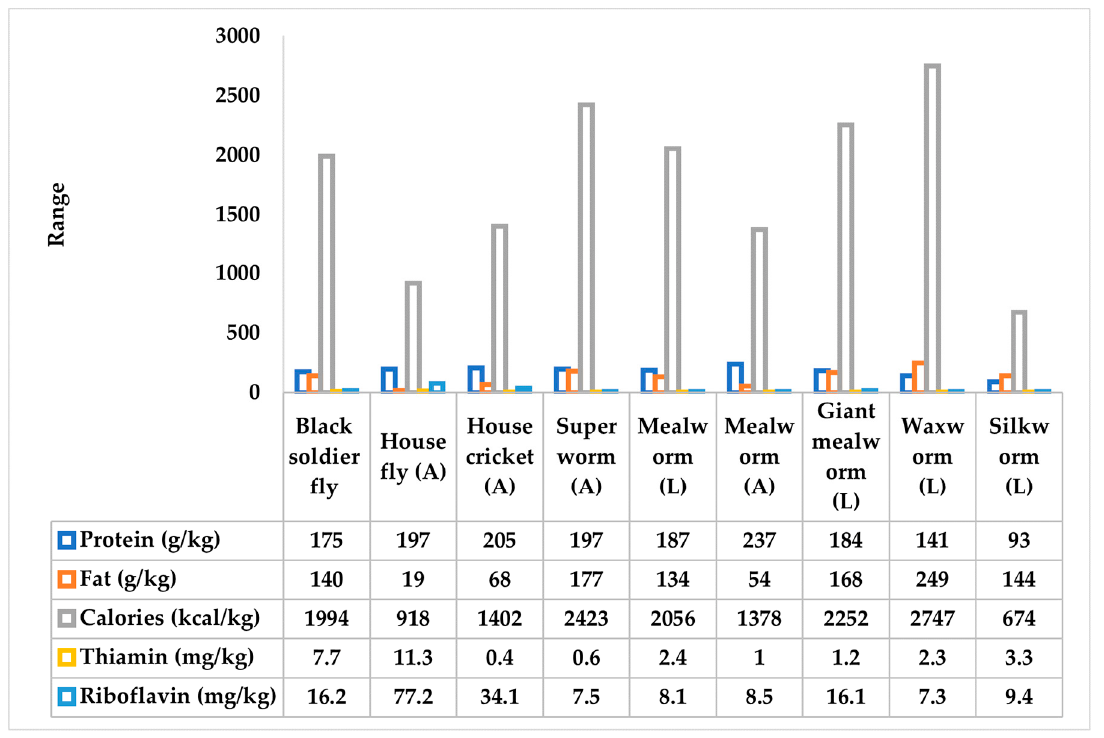
Figure 1. Nutritional value of potential insects used as fish feed. Reproduce from sources [80,81] (L = larvae; A = adult).